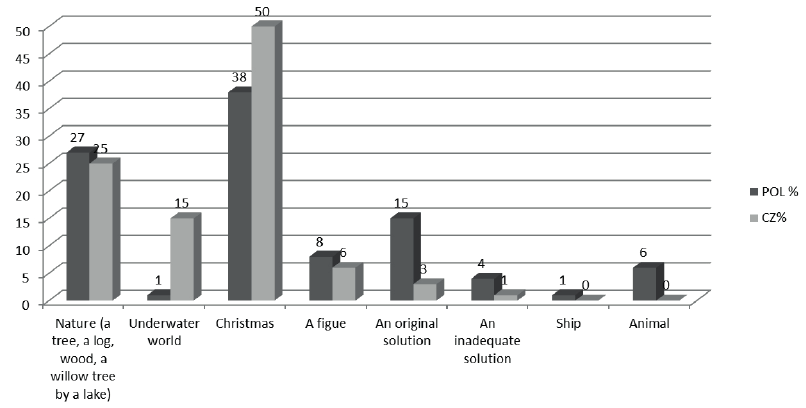
Figure 2. Occurrence of